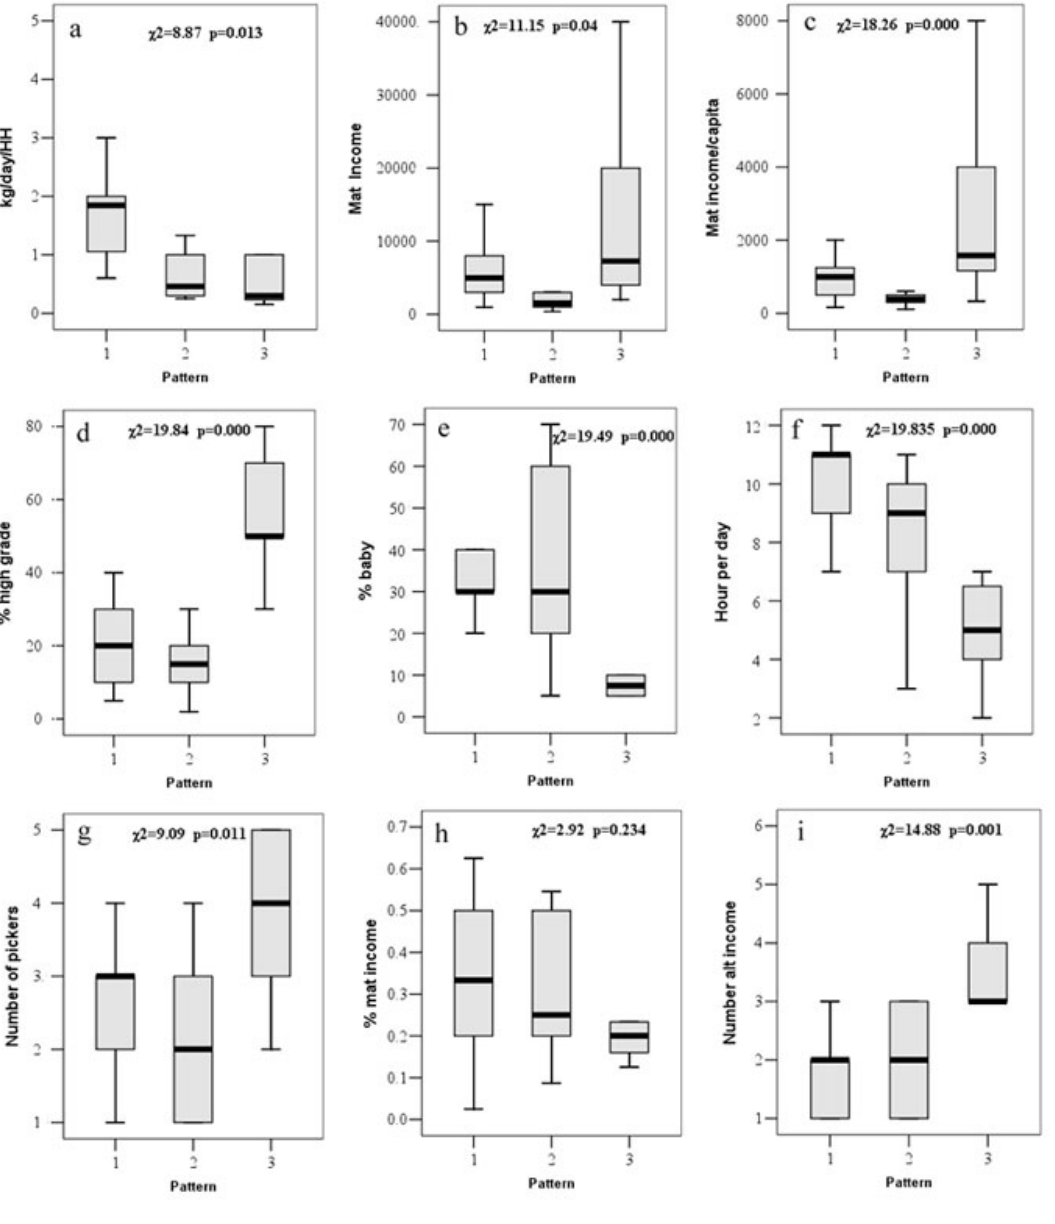
Fig. 4. Differences between the three patterns at household level (a) income generated from matsutake; (b) per capita income from matsutake; (c) percentage of income from matsutake in total household cash income; (d) alternative sources of cash income; (e) percentage of high-grade matsutake harvested per household; (f) percentage of baby matsutake harvested per household; (g) number of pickers per family; (h) hours spent harvesting matsutake per day; (i) average number of kilograms harvested per day per